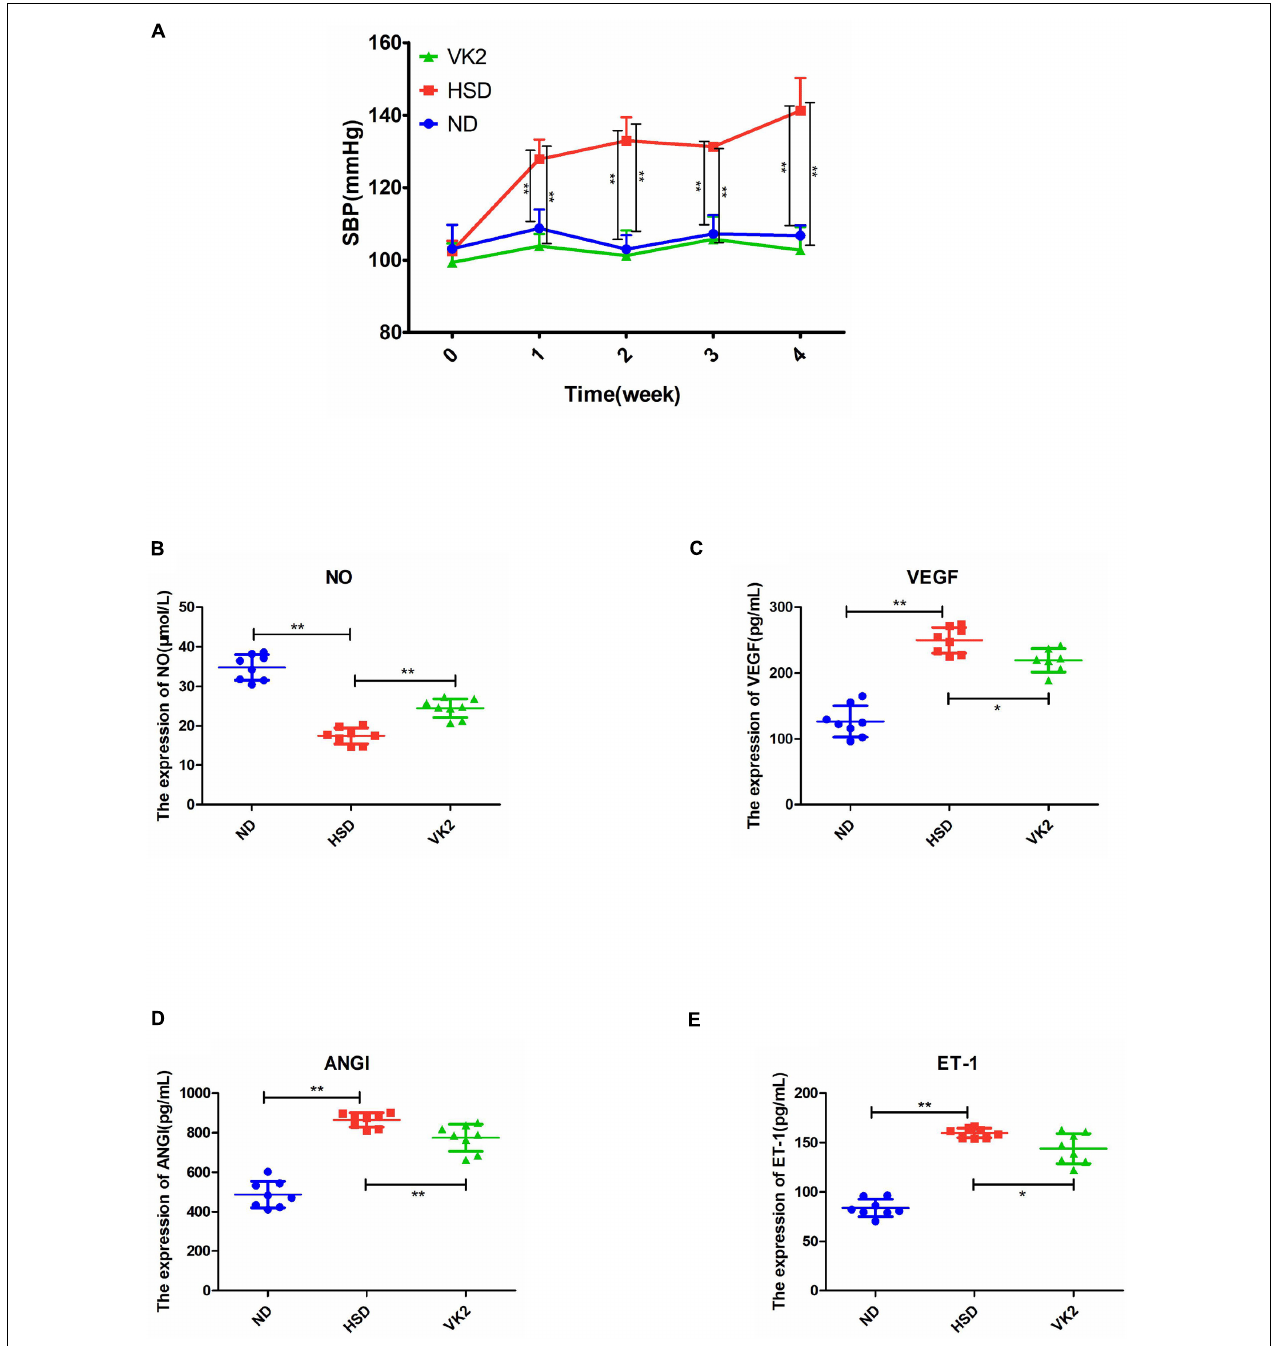
FIGURE 7 | VK2 maintained SBP and altered endothelial function-related factors in high-salt-induced hypertensive mice. (A) VK2 altered SBP. (B) VK2 upregulated the expression of NO. (C) VK2 downregulated the expression of VEGF. (D) VK2 downregulated the expression of ANGI. (E) VK2 downregulated the expression of ET-1. Data are presented as mean ± SD; * p < 0.05 and ** p < 0.01, n = 6–8; statistical comparisons were performed using Student t -test or one-way analysis of variance (ANOVA). SBP, systolic blood pressure; VK2, vitamin K 2 ; NO, nitric oxide; VEGF, vascular endothelial growth factor; ANGI, angiotensin I; ET-1, endothelin-1; ND, WT mice with natural diet; HSD, WT mice with high-salt diet.